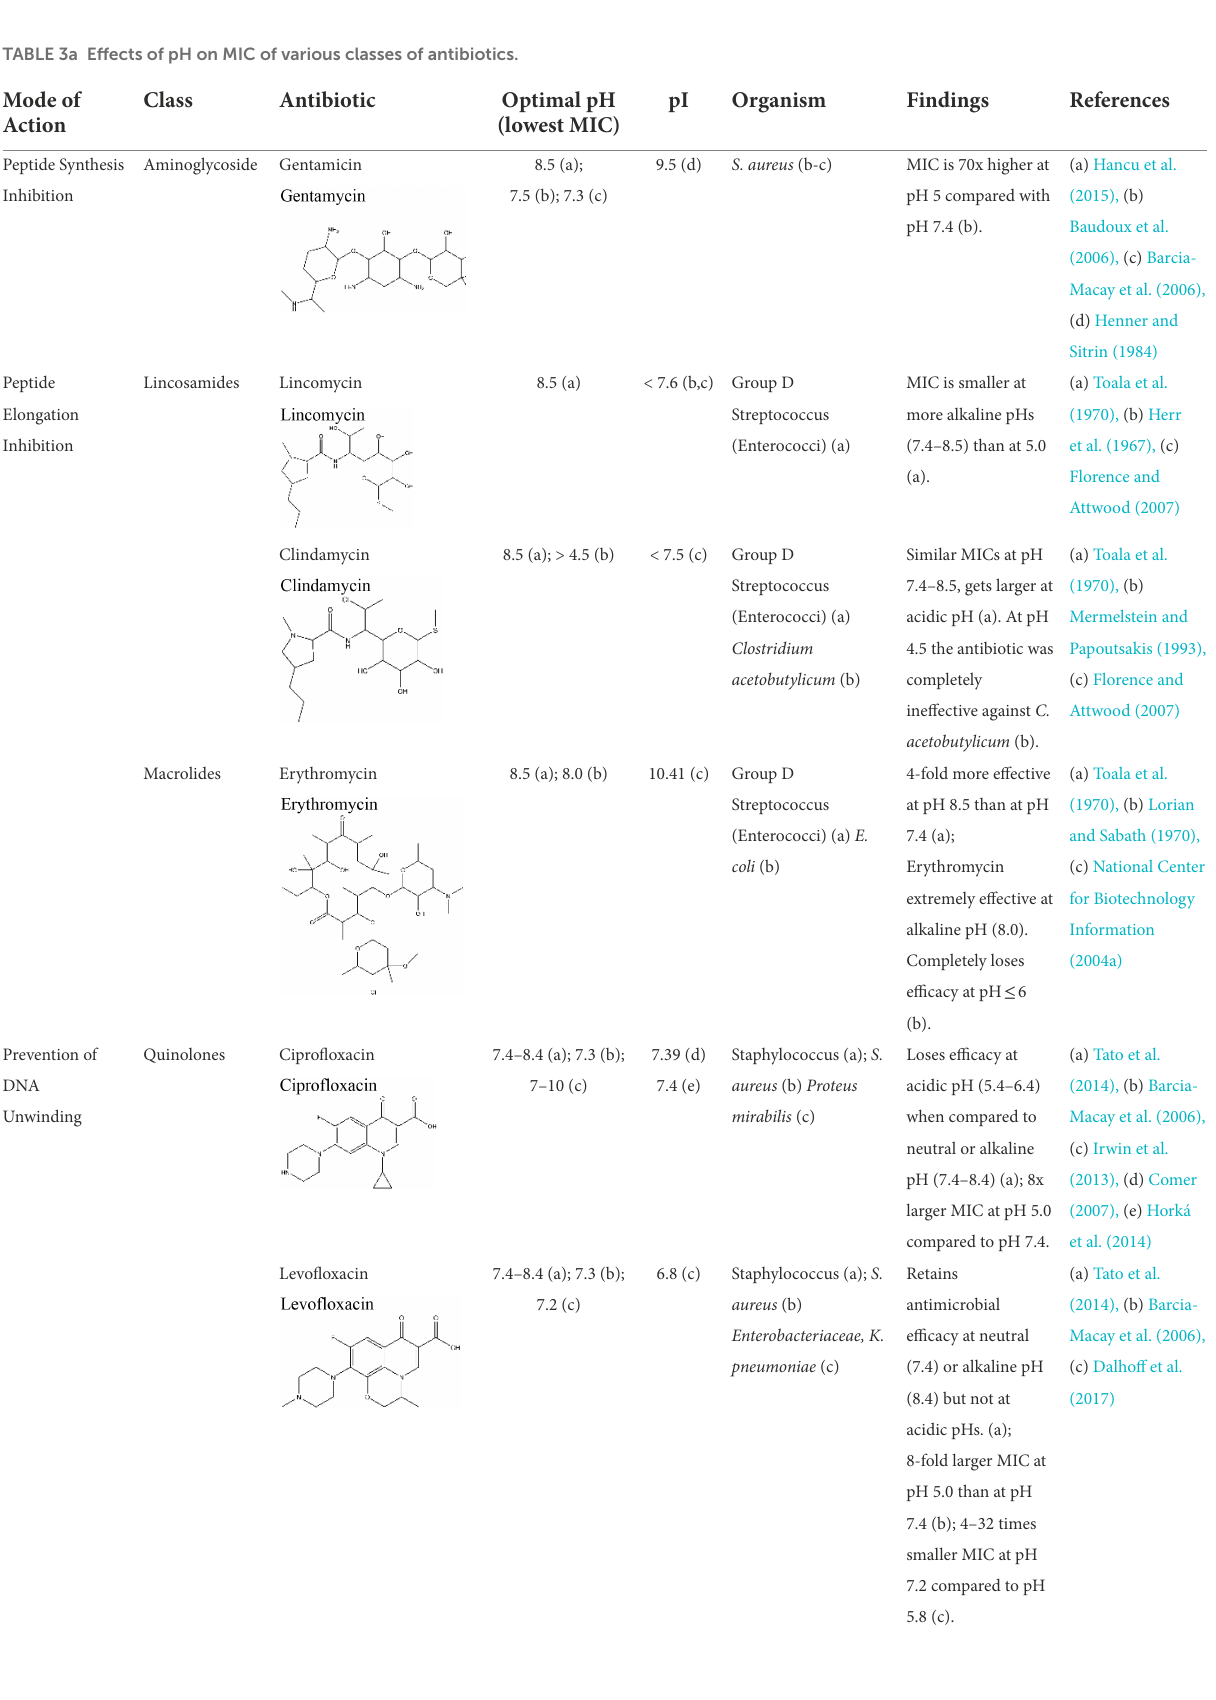
TABLE 3a Effects of pH on MIC of various classes of